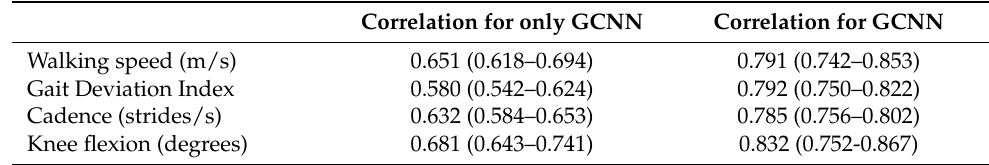
Table 2. Comparison of our proposed graph convolutional neural network (GCNN) depicted in Figures 3 and 4. Here, we observe the method that takes the hand crafted inputs (Figure 4) has a better